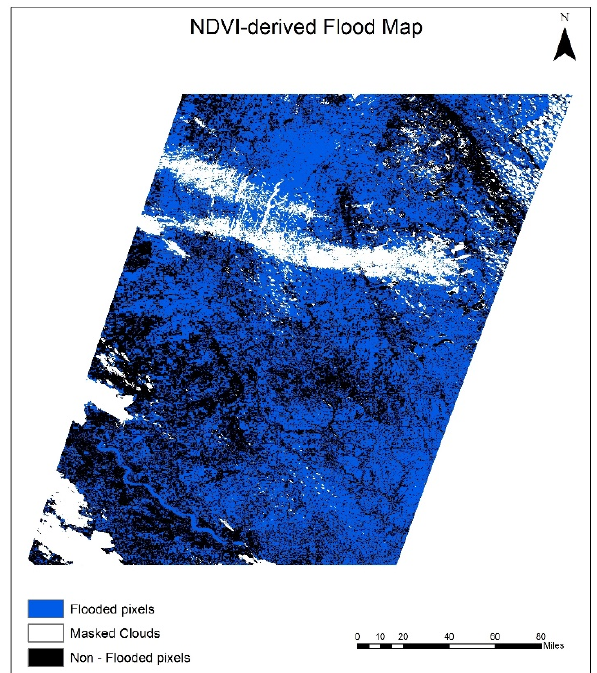
Figure 8. Flood map at 30 m scale generated from NDVI change detection map using threshold value of − 0.243. of −